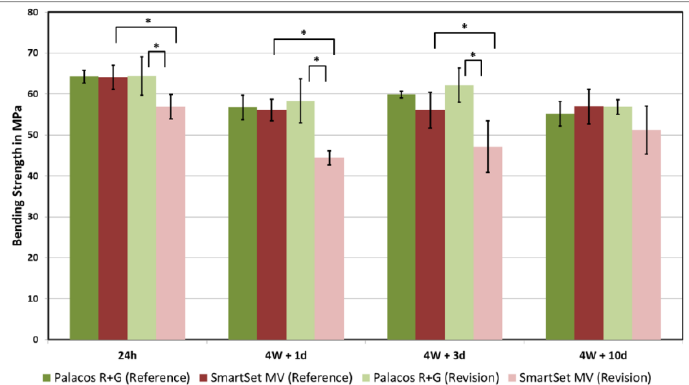
Figure 3. The results of the Bending Strength in MPa. * symbolizes the statistically significant dif- ference between groups ( p < 0.05).